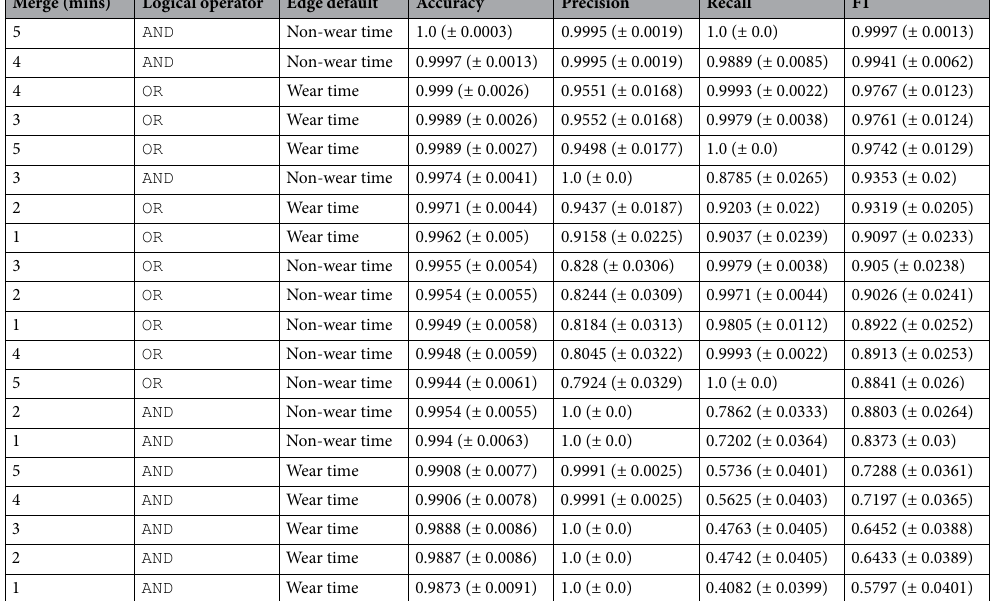
Table 1. The classification of accuracy, precision, recall, and F1 performance metrics when applying the new algorithm on 50% of the available data ( n = 291/583) while exploring 20 combinations of hyperparameter values; 95% confidence intervals are shown between parentheses. Merge (mins) = the merging of neighbouring candidate non-wear episodes to handle artificial movement. Logical operator = AND if both start and stop segments or OR if only one side of a candidate non-wear episode needs to be classified as true non-wear time to subsequently classify the candidate non-wear episode as an episode of true non-wear time. Edge default = the default classification of a candidate non-wear episode that has no start or end segment, such cases that occur right at the beginning or end of the acceleration data and default to wear or non-wear